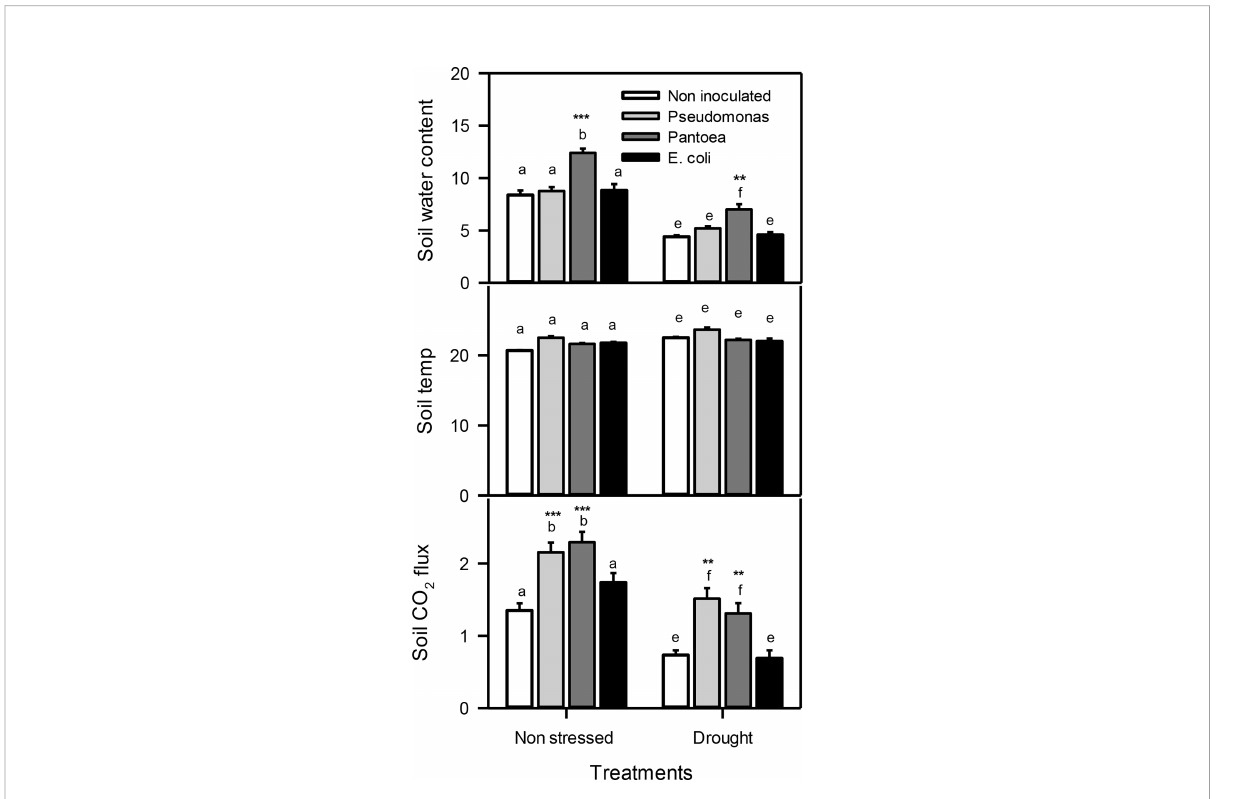
FIGURE 2 Soil water content, soil temperature (temp), and soil CO 2 fl ux of drought-stressed and non-stressed (well-watered) Hordeum vulgare inoculated with three bacterial strains ( Pseudomonas sp. (ITS Group 11), Pantoea sp. (ITS Group 2), or E. coli ). F and P (***P< 0.001, **P< 0.01) values of the two-way ANOVAs are presented, drought, bacteria and drought x bacteria interaction. The lower case letters shows the signi fi cant differences among means (P< 0.05) assessed by Fisher ’ s protected least signi fi cance difference